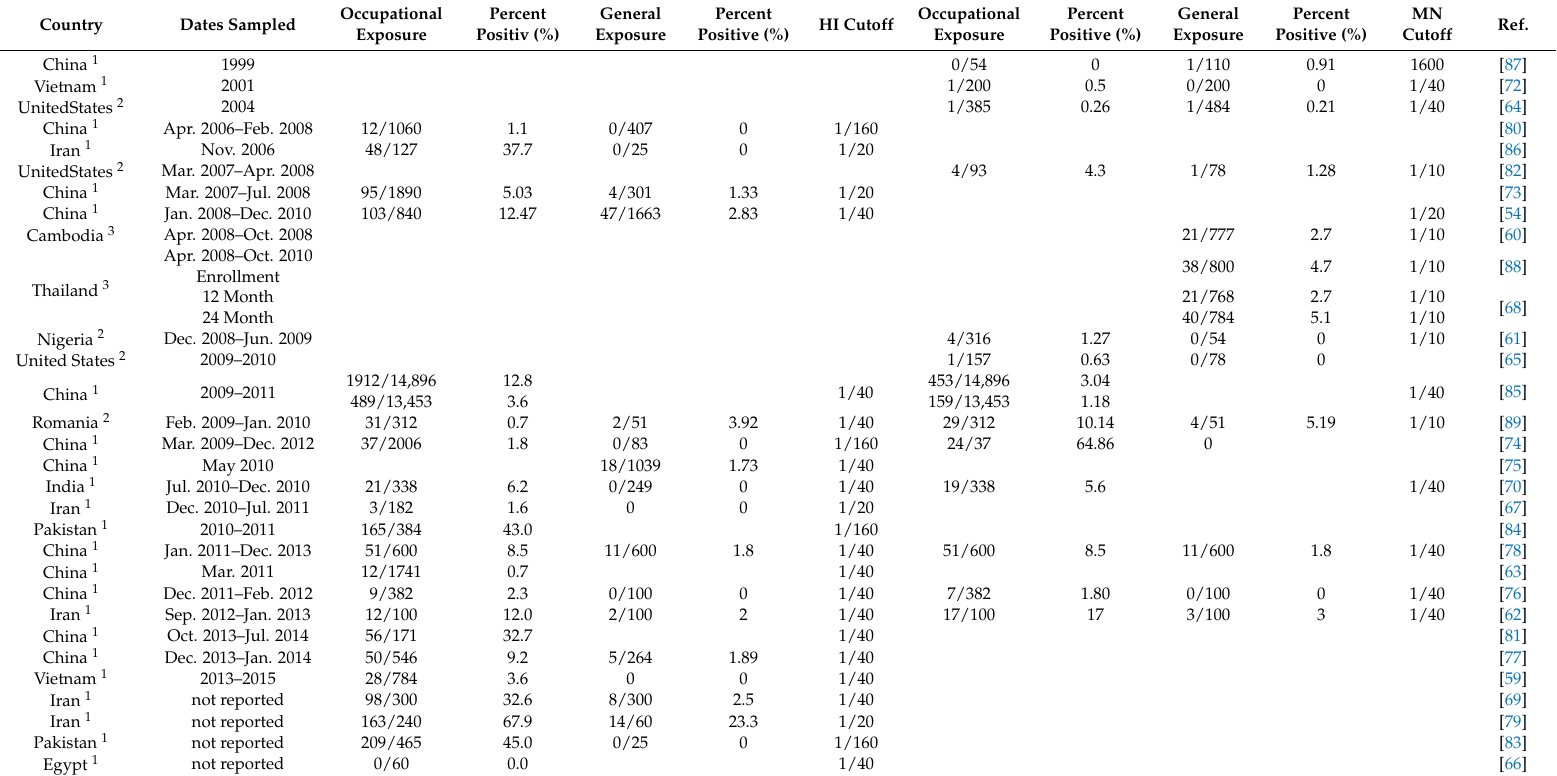
Table 3. H9N2 human serology